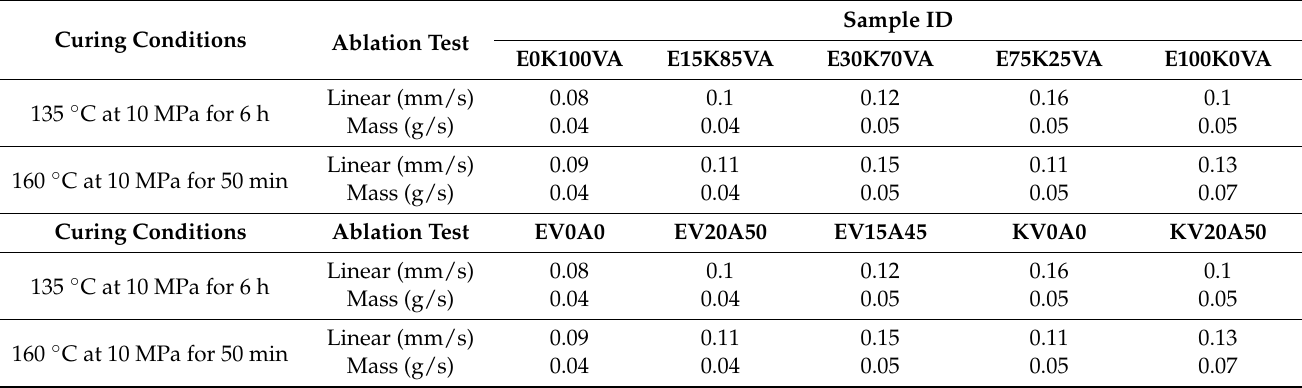
Table 2. Linear and mass ablation values of ablative samples at different curing